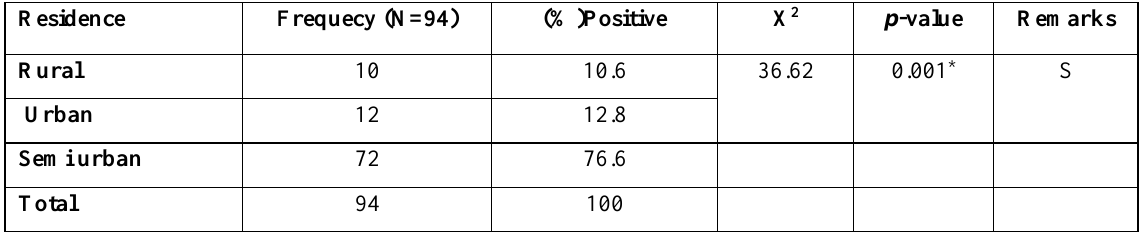
Table 6. Distribution of astrovirus among children in Offa based on location of